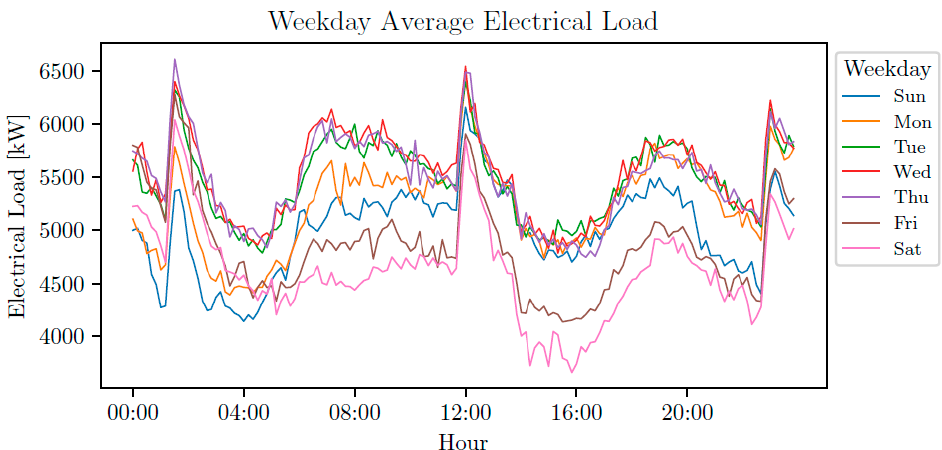
Figure 5. Electrical load: daily average.